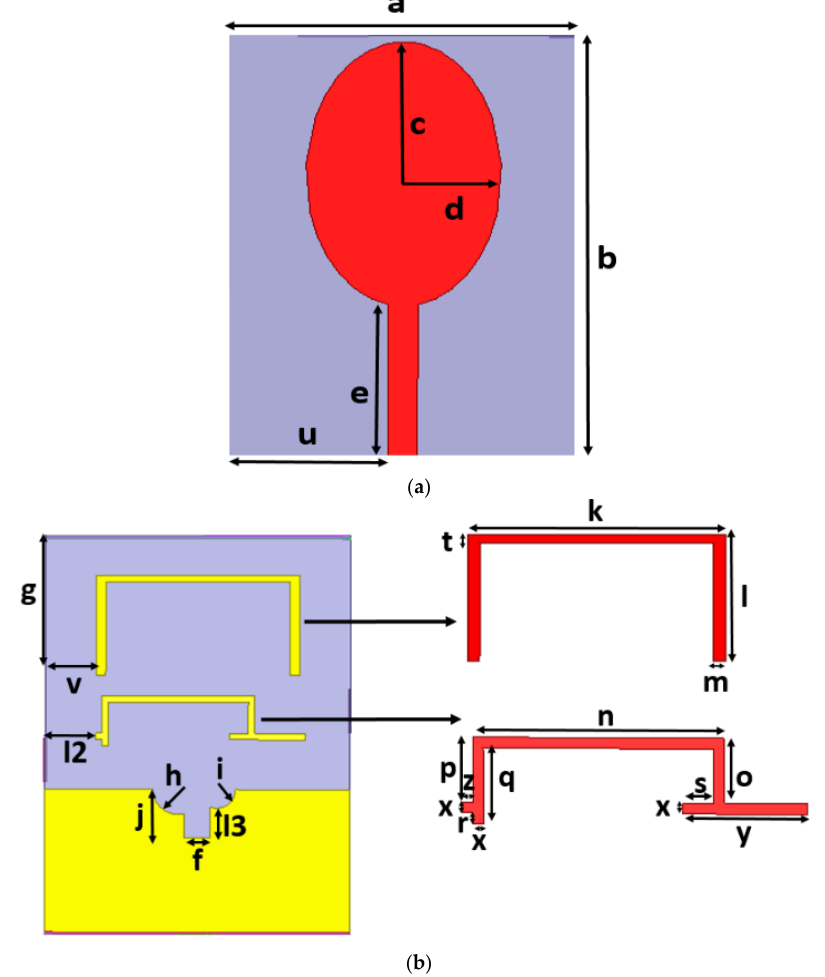
Figure 4. Dimension of elliptical UWB notch antenna: ( a ) patch; ( b ) ground plane. Table 1. Dimension of the proposed antenna. Parameter